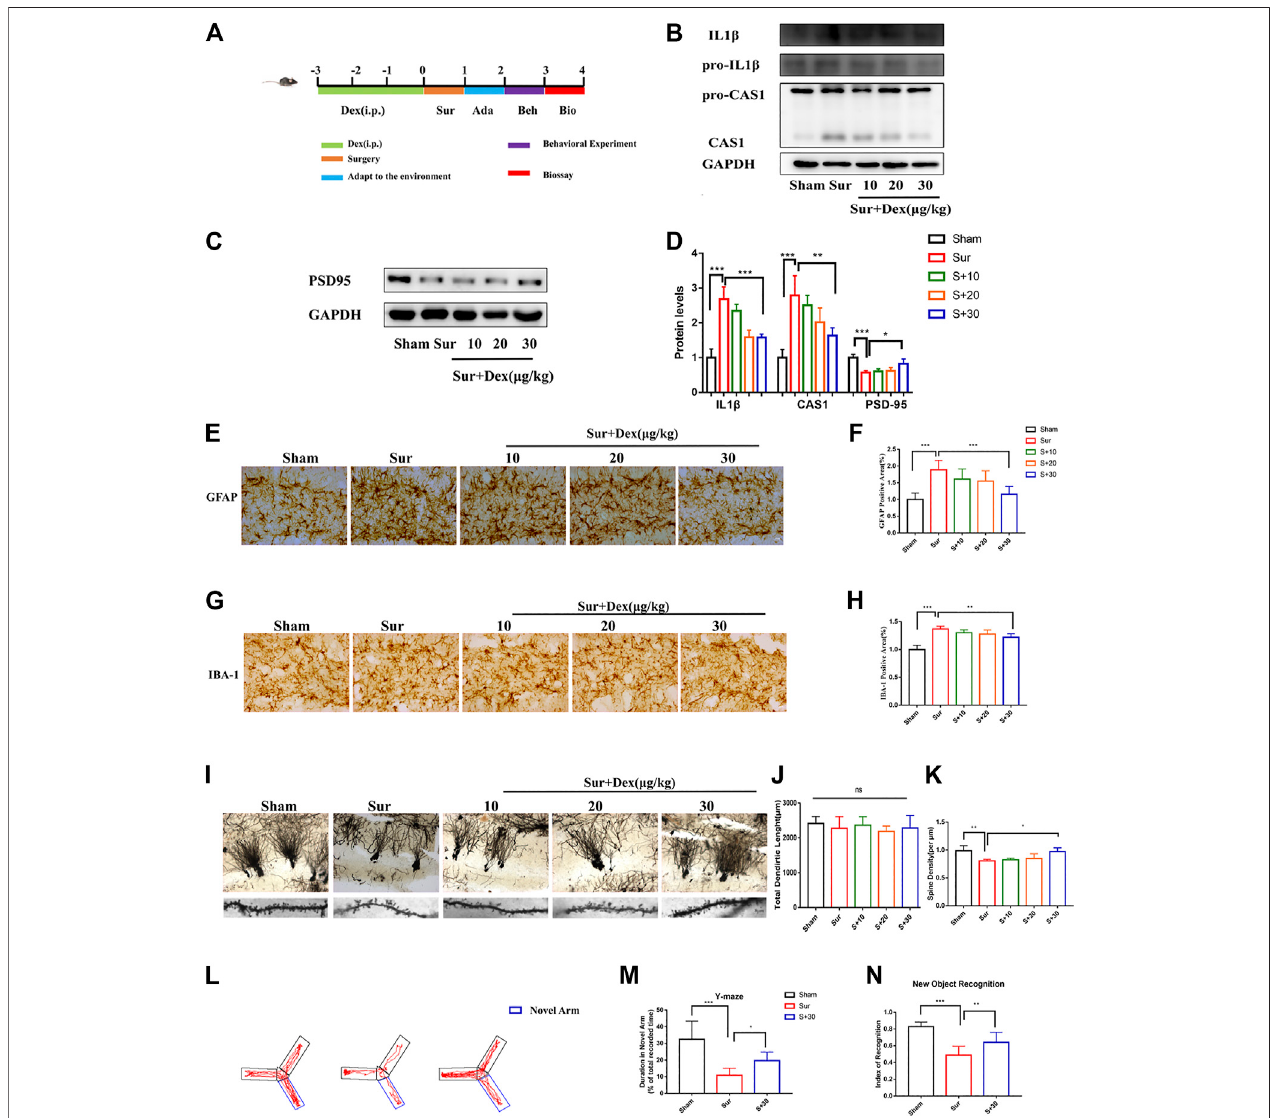
FIGURE2| DEXmitigatedsurgicallyinducednervedamageandreversedcognitivefunctioninmice. (A) Diagramoftheexperimentaldesign,DEXwasgivenoncea day three days before the operation, and the fi rst day after the operation was adapted to the environment of the behavioral test. The biological test was performed after thebehavioraltest.pro-IL1 β /IL1 β ,pro-CASP1/CASP1andPSD95proteinexpressioninthehippocampusweremeasuredbyImmunoblotting (B,C) andthequantitative analysisdatashownin (D) (means ± SEM, n (cid:1) 4).* p < 0.05,** p < 0.01,*** p < 0.001comparedwiththecorrespondinggroup,asdeterminedbytheStudent ’ st-test. The expression ofGFAPand IBA-1wereanalyzed byimmunochemistry in thehippocampal dentategyrus brainregion (E – G) , and thestatistical dataareshown in graph (F – H) (means ± SEM, n (cid:1) 6). Scale bars (cid:1) 100 μ m. Quanti fi cation of the positive areas using ImageJ software. * p < 0.05, ** p < 0.01, *** p < 0.001 compared with the corresponding group, as determined by the Student ’ s t -test. The hippocampus of the sections were examined by Golgi-Cox Staining (I) , the pictures taken were analyzed with the NeuroJ plugin in ImageJ software to calculate the total length of dendrites and the density of synaptic spines ( J,K , n (cid:1) 6). * p < 0.05, ** p < 0.01, *** p < 0.001 compared with the corresponding group, as determined by the Student ’ s t-test. Y-maze and new object recognition were tested of mice at the end of the experiment(means ± SEM, n (cid:1) 10),theY-mazetraceofthemicewereshownin (L) ,andthequantitativeanalysisdatashownin (M – O) .* p < 0.05,** p < 0.01,*** p < 0.001 compared with the corresponding group, as determined by the Student ’ s t